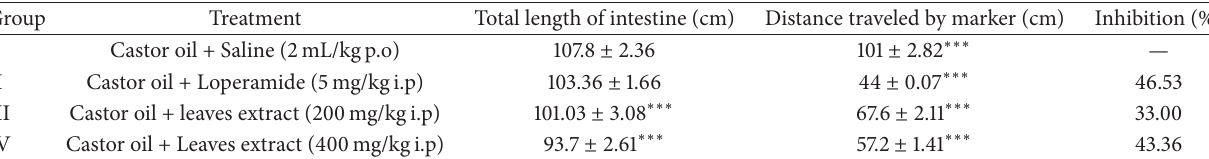
Table 3: Effect of MEMA leaves on small intestinal transition in rats.